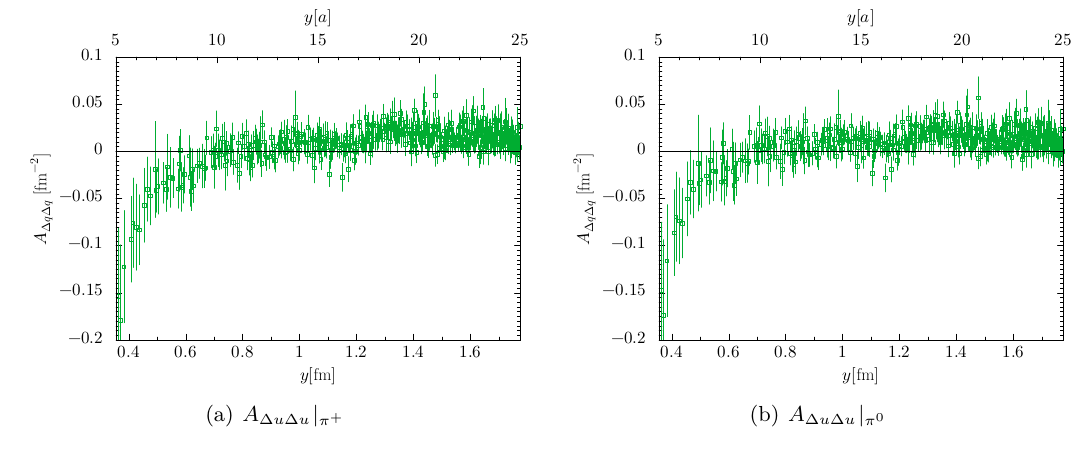
Figure 24 . Continuation of figure 23.